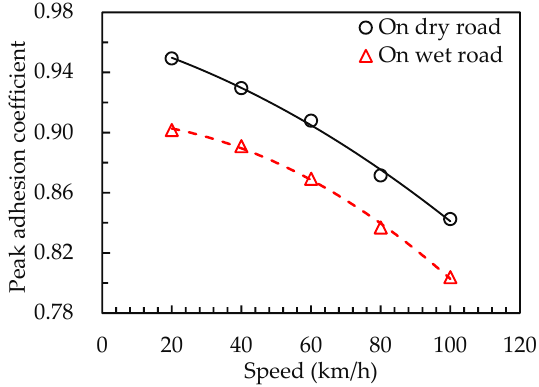
Figure 5. Peak adhesion coefficient curves of asphalt pavement.